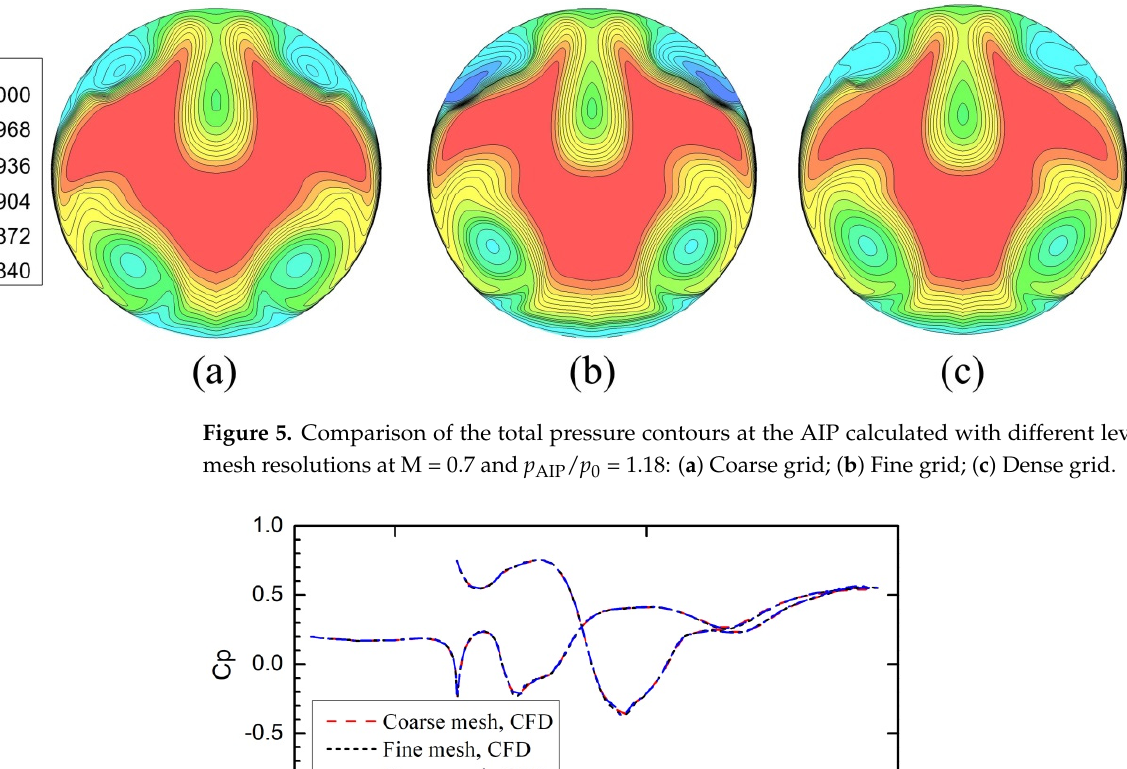
Table 3. Inlet performance calculated with different resolved meshes at M = 0.7 and p AIP / p 0 = 1.18.